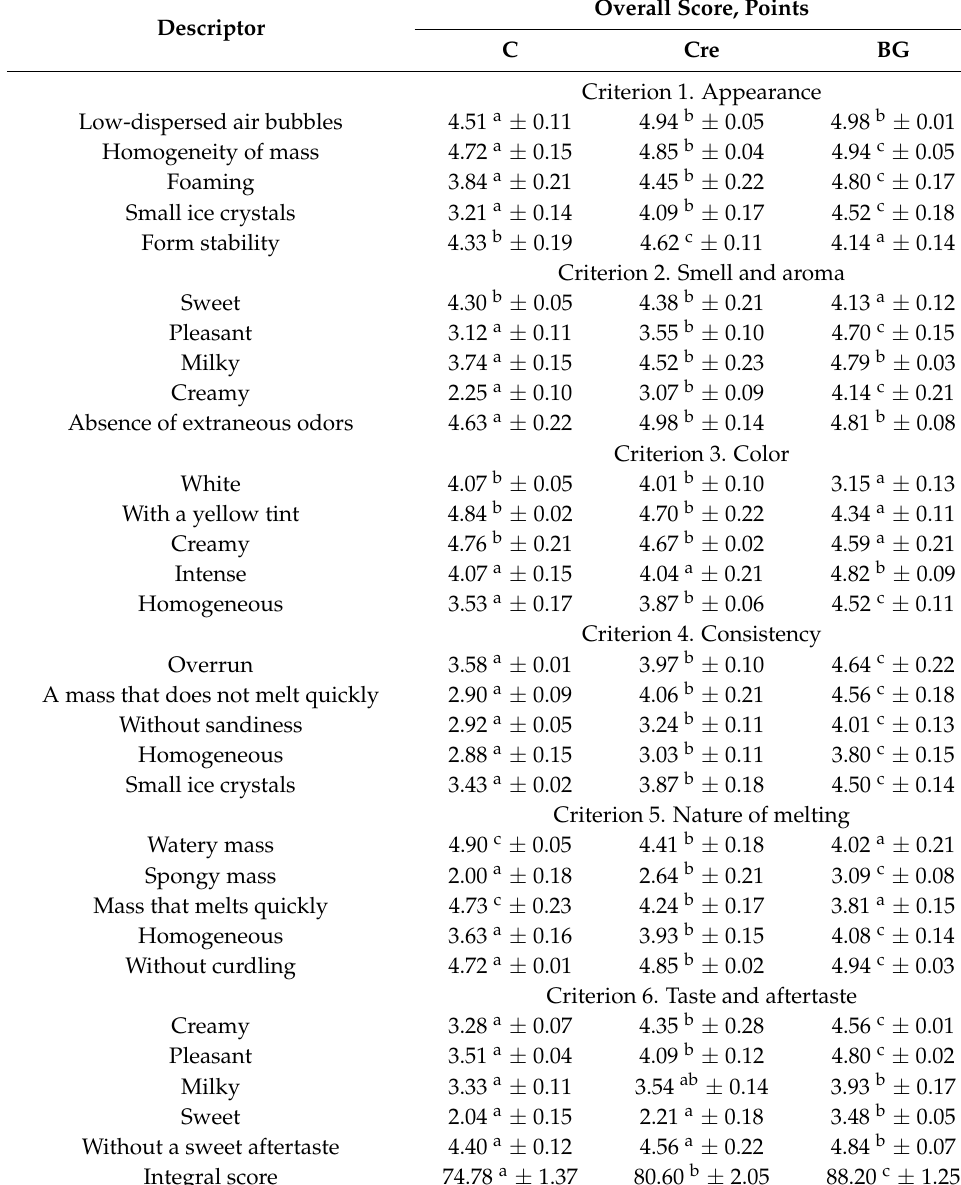
Table 5. Sensory evaluation of ice cream